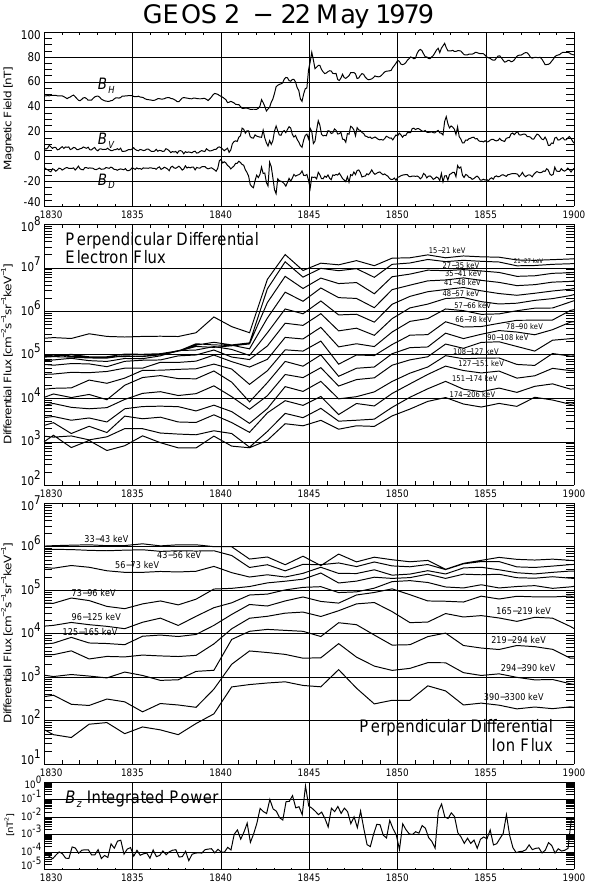
Fig. 4. SCATHA measurements as functions of time. From top to bottom: 1. Three magnetic field components, 2. Differential high energy electron flux intensity. 3. Differential high energy ion flux intensity. 4. Integrated power of magnetic field oscillations in fre- quency range 1.0–2.0